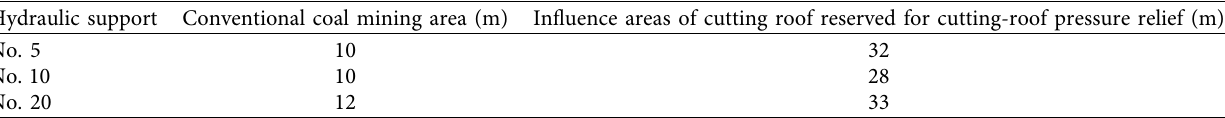
Figure 5: Load curves of support pillars in areas affected by roof cutting in the roof-unloading, retaining roadway: (a) No. 5, (b) No.10, and (c) No. 20. Table 1: Pressure cycle steps and pressure in areas affected by roof cutting in the